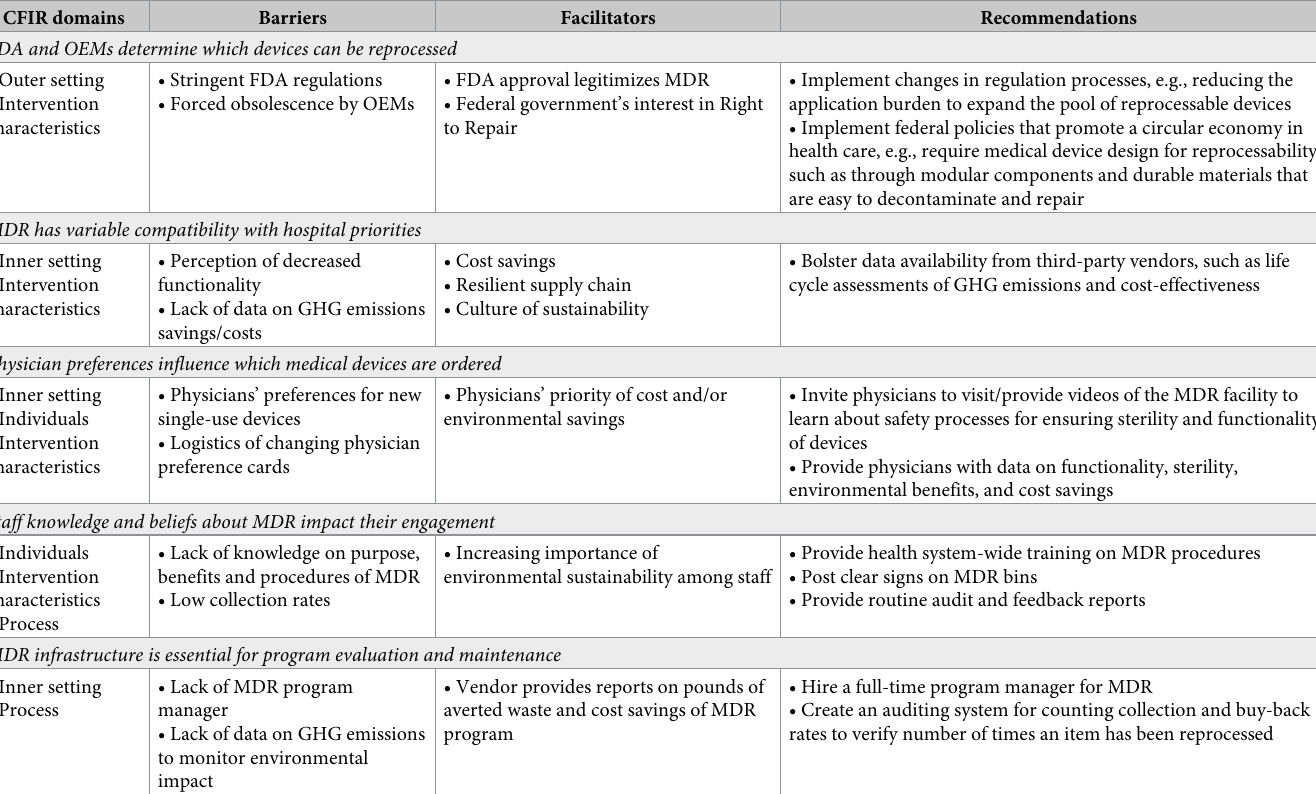
Table 2. Barriers, facilitators, and recommendations to scale up